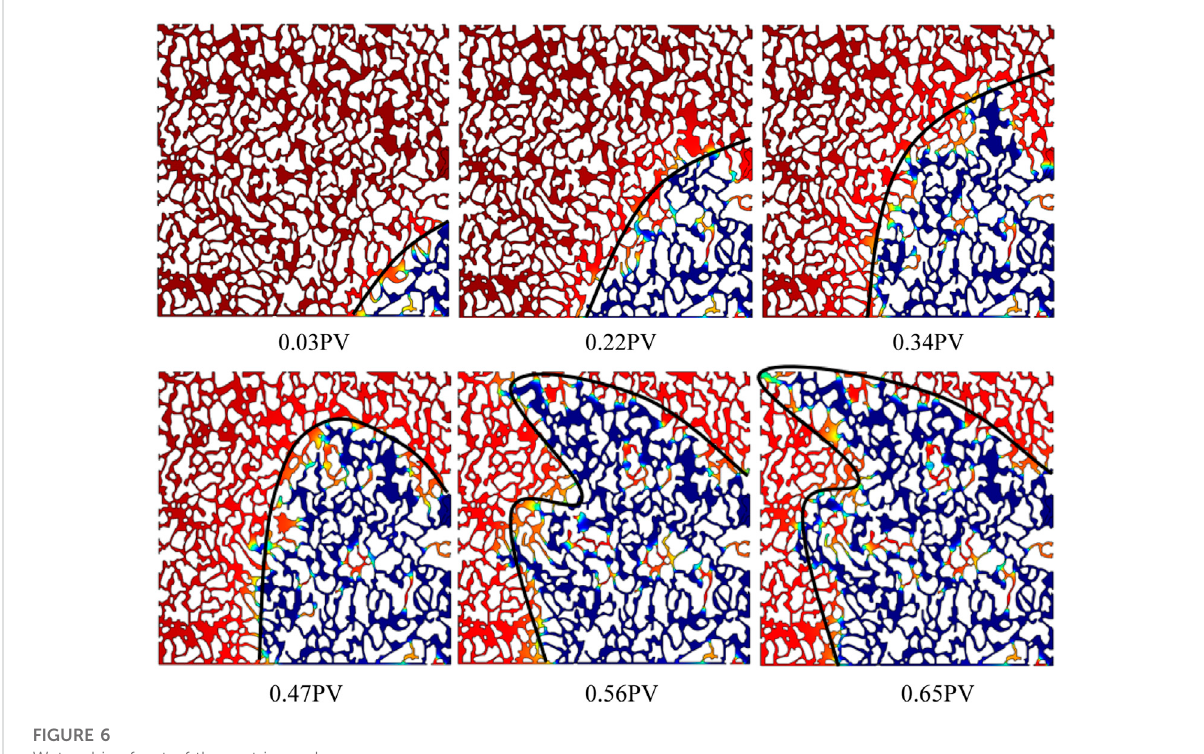
FIGURE 6 Water drive front of the matrix